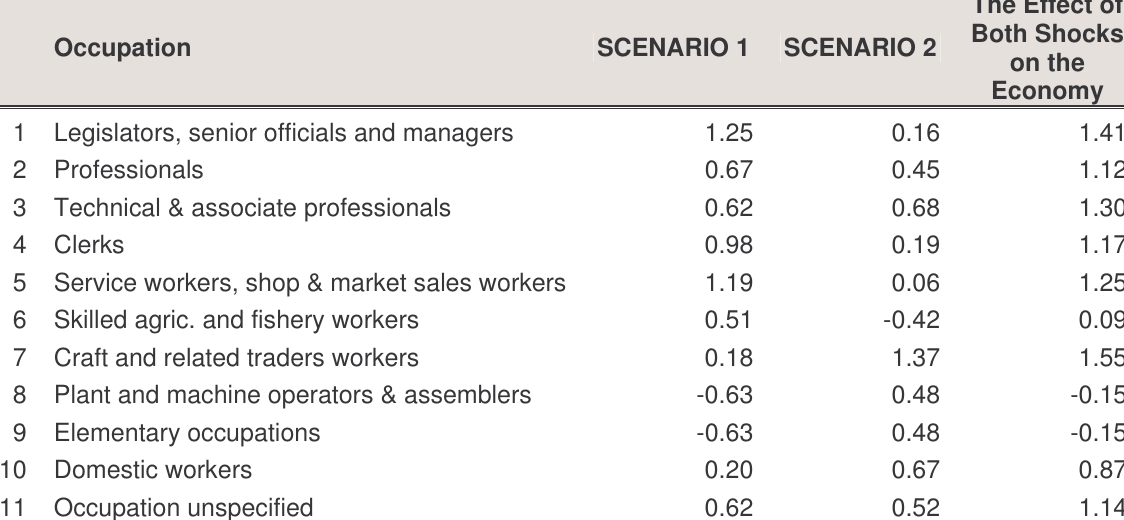
Table 6: Aggregate employment